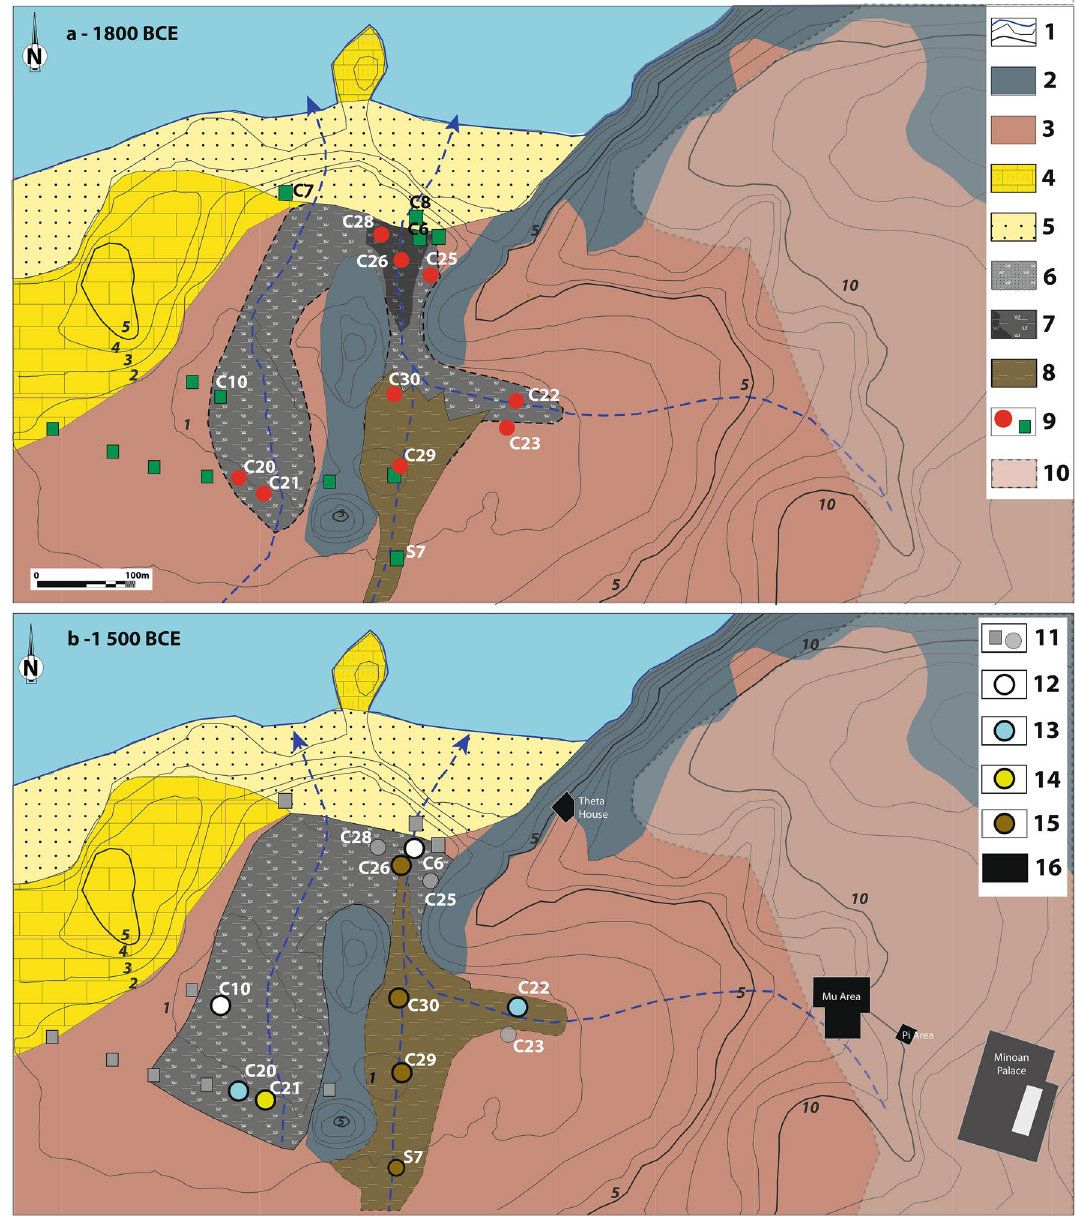
Figure 3. The wetland of Malia before (a: 1800 years BCE) and after (b: 1500 years BCE) the Bronze Age eruption of the Santorini volcano. A- 1. Hypothetical coastal line (blue) and contour line (grey, 1 m eq., elevation indicated for 1–5 m and 10 m contour lines). 2 Cretaceous limestone (Sidheropetra); 3. Pleistocene deposits; 4. Pleistocene Calcarenite; 5. Beach barrier sand; 6. Sandy marshy deposits; 7. Silt to silty-clay organic sedimentation: marshy deposits. The dark grey applet on ( a ) corresponds to the limit of the marsh deposits c. 5000 BCE; 8. Light brown silt: colluvial and fluvial deposits; 9. Core drillings 2015 (red dot) and ante 2015 (green square); 10. Main excavated area of the Minoan town of Malia. ( b ) Evidence of tsunami impact; 11. No clear evidence of tsunami impact; 12. Sharp sedimentary erosional contact; 13. Layer with allochtonous microfaunal marine fossils; 14. Tsunami deposits; 15. Post-tsunami continental sedimentation. 16. Minoan buildings cited in the text including the Minoan palace with its central court (white rectangle). Edited in Adobe Illustrator CS6 2020 version lying dark grey silt marsh deposits (U3). The U4 sand layer is significantly different from these fine silty deposits (D50: 5–10 µm) which both precede and follow it. The main sand unit is 20 cm thick (U4a), characterized by a multimodal composition revealing a mixture of well-sorted medium sand and fine silt (D50: 83–18 µm) with a general normal-graded sequence. It comprises marine mollusks and echinoderms fragments. The next subunit (U4b) corresponds to a silty layer (D50: 7–8 µm) overlain by a final 6 cm layer of medium sand (U4c) with grain size characteristics (D50: 33 µm) very close to the main subunit. The sand deposits of U4 also differ from the sur-